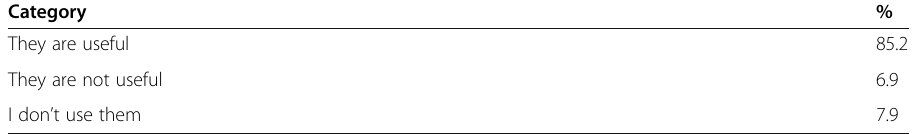
Table 5 Do you think that using IELTS preparation materials is useful to you in IELTS?